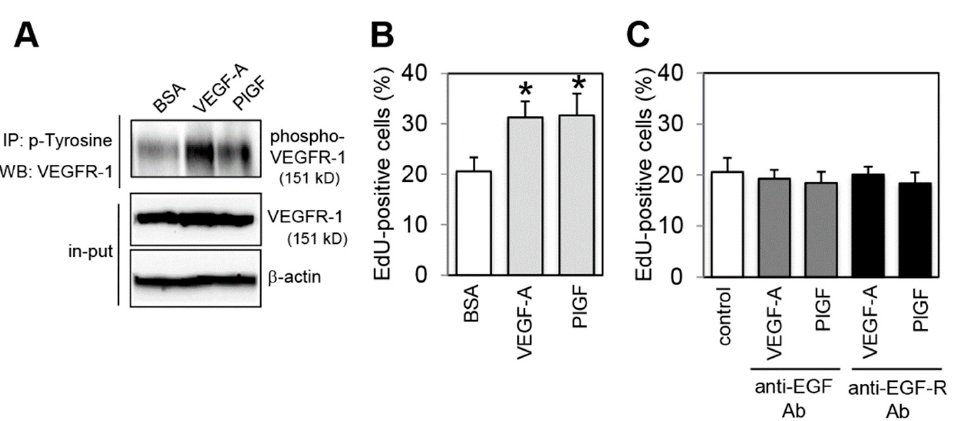
Figure 1. Vascular endothelial growth factor receptor-1 (VEGFR-1) activation results in increased proliferation activity that depends on autocrine epidermal growth factor (EGF) / EGF receptor (EGF-R) pathway. ( A ) Activation of VEGFR-1 by vascular endothelial growth factor-A (VEGF-A) and placental growth factor (PlGF) stimulation. Cells were treated with VEGF-A, (PlGF) or control bovine serum albumin (BSA) for 5 min. Phosphorylated VEGFR-1 was detected by immunoprecipitation with an anti-phospho-tyrosine antibody and immunoblotting with an anti-VEGFR-1 antibody. The same lysates (10% input) were immunoblotted with an anti-VEGFR-1 antibody to normalize the amounts of each sample. The levels of β -actin are shown as a loading control. ( B ) Quantification of EdU (5-ethynyl-2’-deoxyuridine) positive cells under VEGFR-1 activating conditions. Data are indicated by means ± SD ( n = 6–8). * p < 0.01, statistically significant increase compared with the BSA-treated control cells. ( C ) Quantification of EdU positive cells under EGF / EGF-R inhibiting conditions. Cells were pretreated with neutralizing antibodies against EGF (anti-EGF Ab) and EGF-R (anti-EGF-R Ab), or control non-immune IgG (control) for 1 h, and then treated with VEGF-A or PlGF for 24 h. Data are indicated by means ± SD ( n =